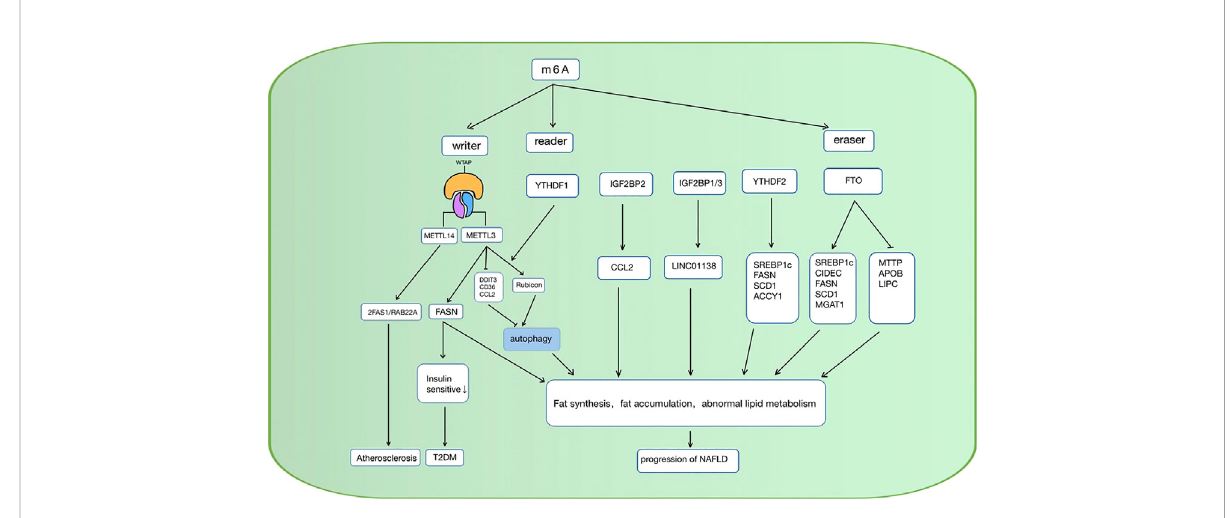
FIGURE 3 RNA m6A regulators are involved in the regulation of lipid metabolic diseases in various ways. NAFLD, non-alcoholic fatty liver disease; CCL, C- C motif chemokine ligand 2; SREBP1c, sterol regulatory element-bindin protein-1; FASN, Fatty acid synthase; SCD1, stearoyl-CoA desaturase; ACCY1, acetyl-CoA carboxylase, CIDEC, cell death-inducing DFF45-like effector C; MAGAT, monoacylglycerol acyltransferases; LIPC, hepatic lipase; APOB, apolipoprotein; ZFAS1/RAB22a, zinc fi nger antisense 1/ras-related protein rab-22a; DDIT3, DNA damage-inducible transcript 4; T2DM, diabetes mellitus type 2; METTL, methyltransferase-like 3; YTHFD, YT521-B homology domain family; FTO, fat mass and obesity- associated protein; IGFBP, Insulin-like growth factor-binding proteins; MTTP, microsomal triglyceride transfer